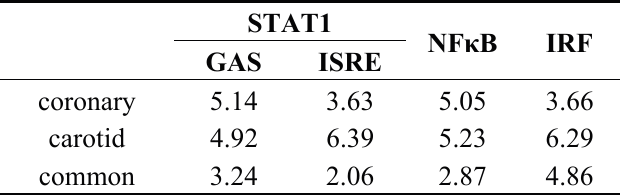
Table 2. Over-representation of regulatory elements in promoters of genes from all datasets. nuclear factor kappa-light-chain-enhancer of activated B cells (NF κ B) and interferon-regulated factor (IRF) refer to signal transducer and activator of transcription-1